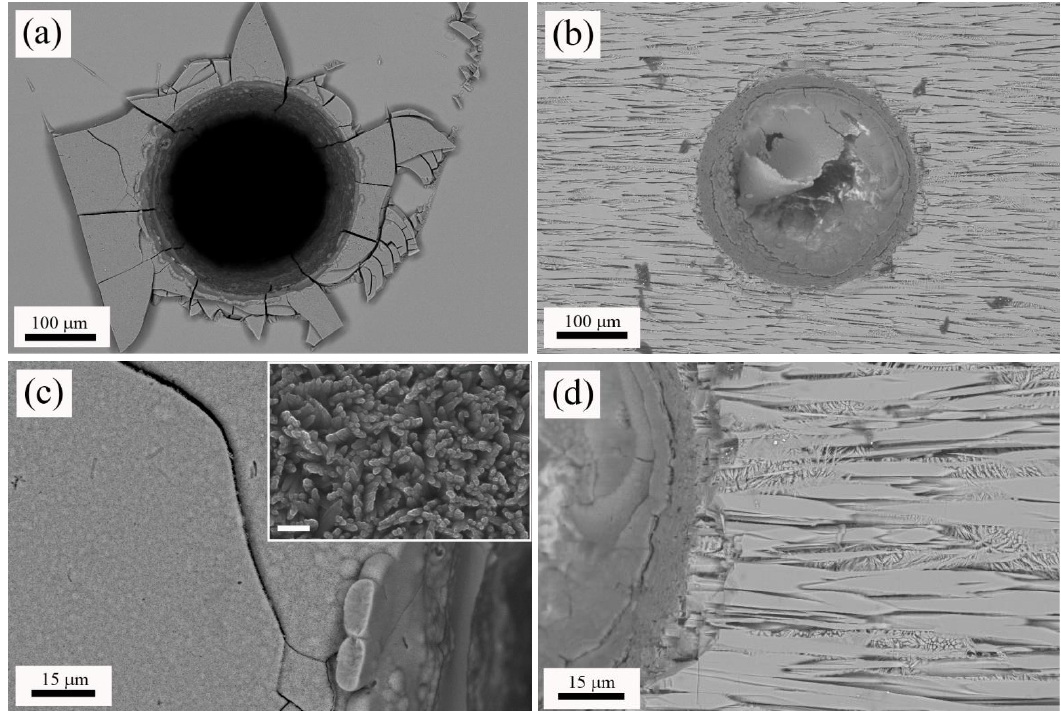
Figure 4. Top-view micrographs of the machined glass ( a ) and glass-ceramic ( b ) after 2 months immersed in SBF, and details of the microstructure in the surroundings of the processed area in the glass ( c ) and glass-ceramic ( d ). The scale bar in the inset of micrograph ( c ) is equal to 200 nm.